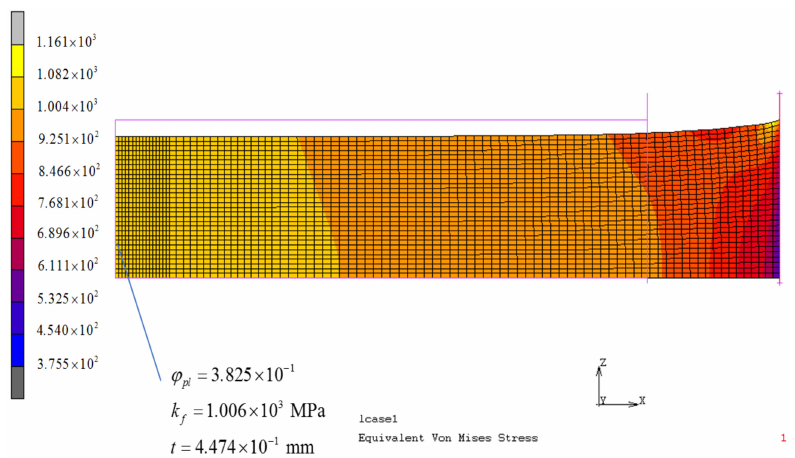
Figure 13. FEM tensile test